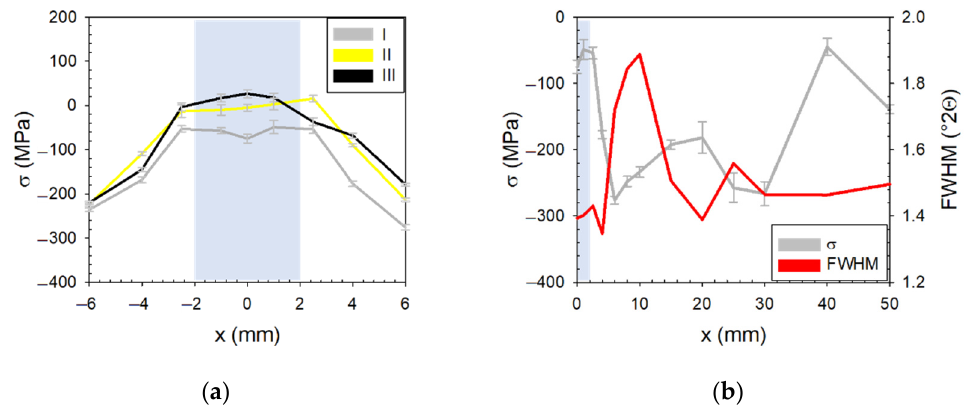
Figure 8. ( a ) Macroscopic residual stresses of the longitudinal weld in the transversal direction and ( b ) macroscopic residual stresses and FWHM parameter of the area I. The blue area denotes the position of the longitudinal weld [22].